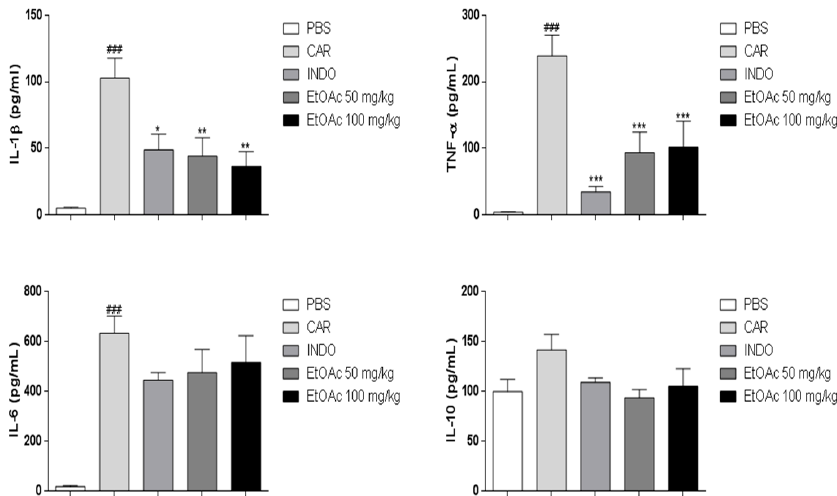
Figure 8. Levels of IL-1b, TNF- α , IL-6 and IL-10 (produced after carrageenan administration) in the presence of the ethyl acetate phase (EtOAc) of A. occidentale . Results were expressed as mean SEM and analysed by graphpad Prism using ANOVA followed by the test Dunnett or Mann–Whitney, where all groups were compared. ### p < 0.001 versus PBS group and * p < 0.05; ** p < 0.01; *** p < 0.001 versus the carragenan group.